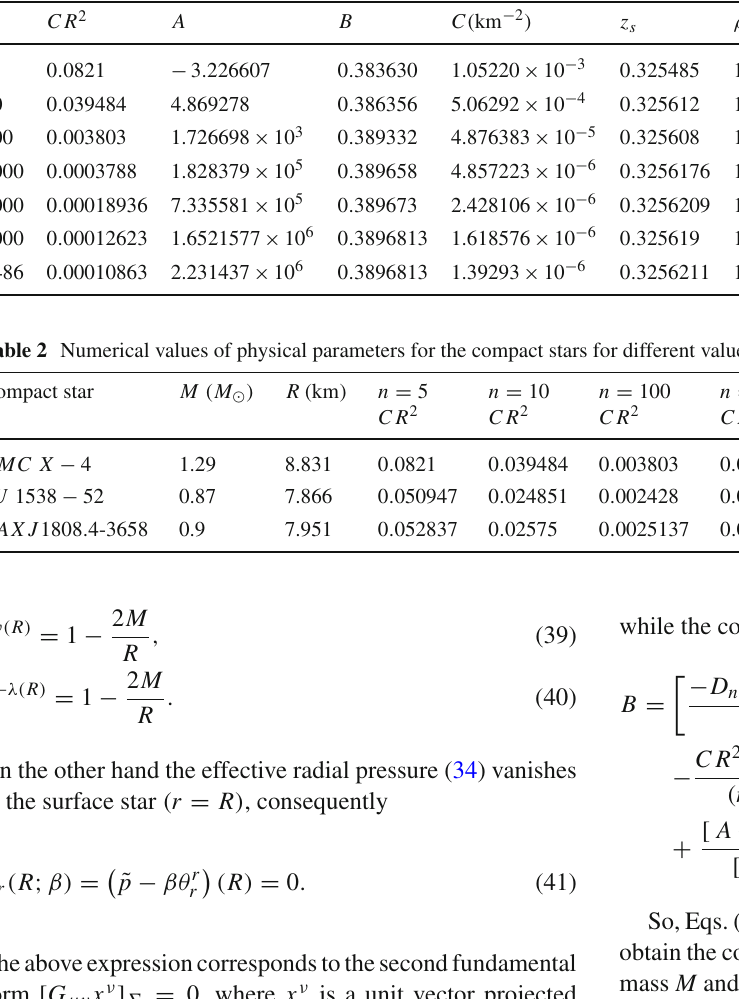
Table 1 Physical parameters values of the compact star LMC X − 4 with mass M = 1 . 29 ( M (cid:6) ) and predicted radius R = 8 . 831 ( km ) , β = 0 . 4 for different values of n [120]